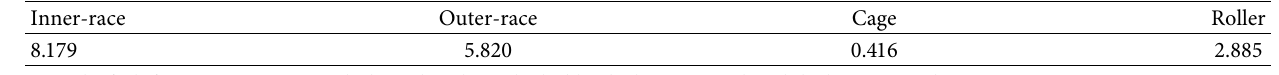
Table 3: Characteristic parameters of bearing fault.